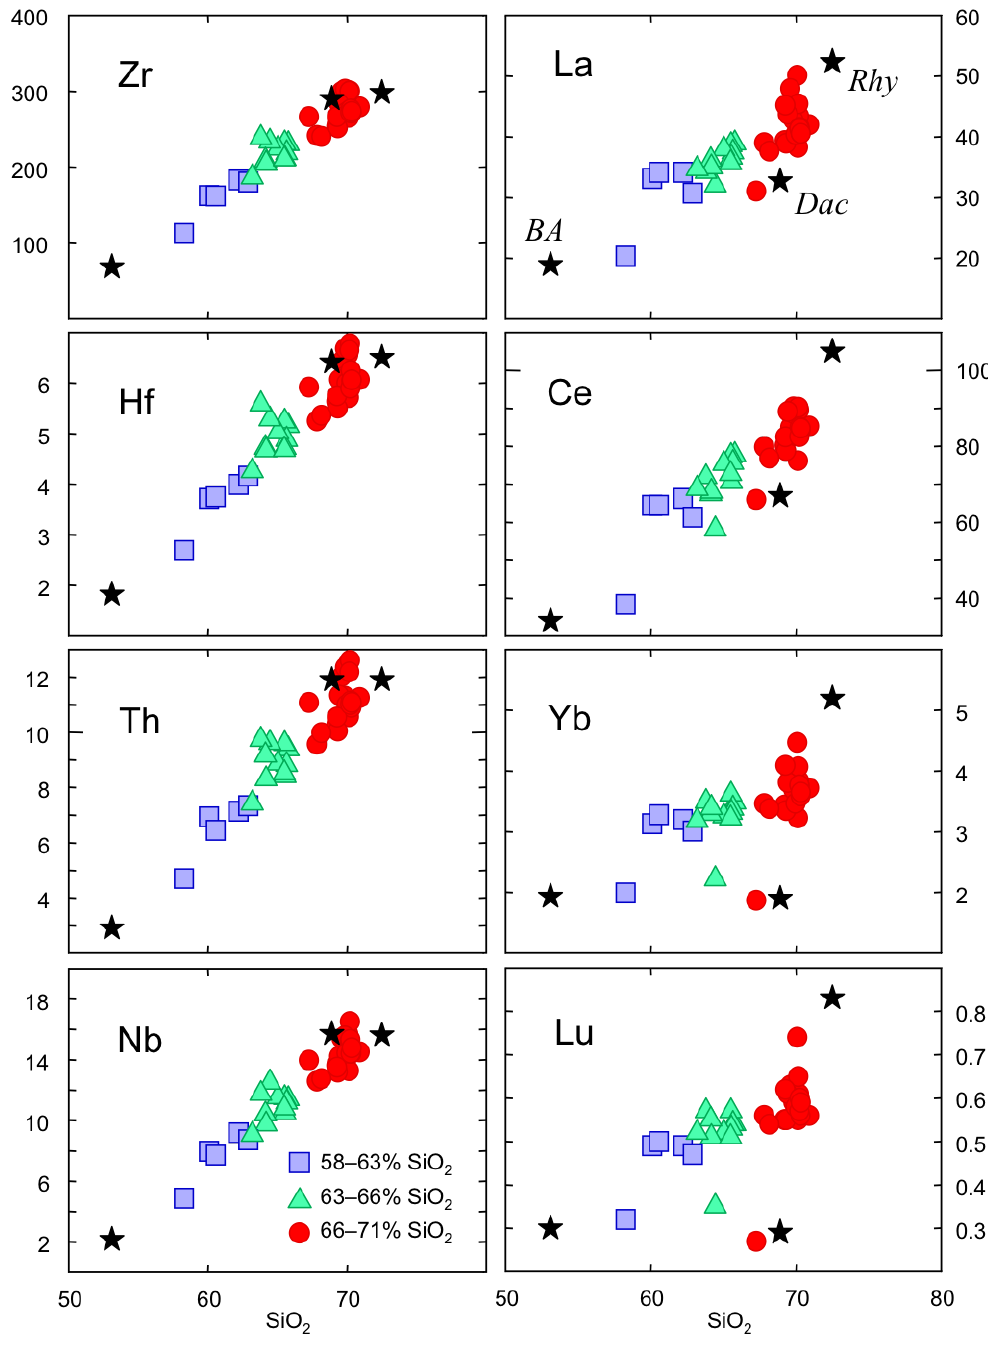
Figure 4. Select trace elements (ppm) plotted against wt % SiO Black stars on chemical variation diagrams show three end member mixing compositions predicted by PVA and are explained in the